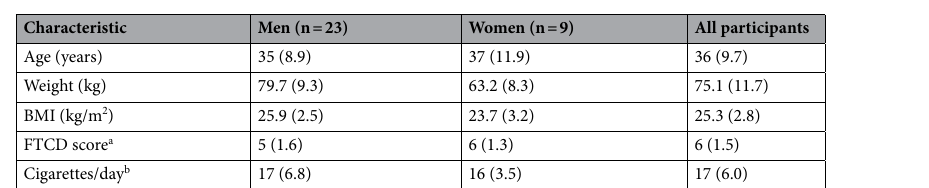
Table 1. Demographic characteristics of study participants. Values are presented as mean (standard deviation). BMI body mass index. a Fagerström test for cigarette dependence (FTCD) score at screening. b Self- reported daily cigarette consumption at